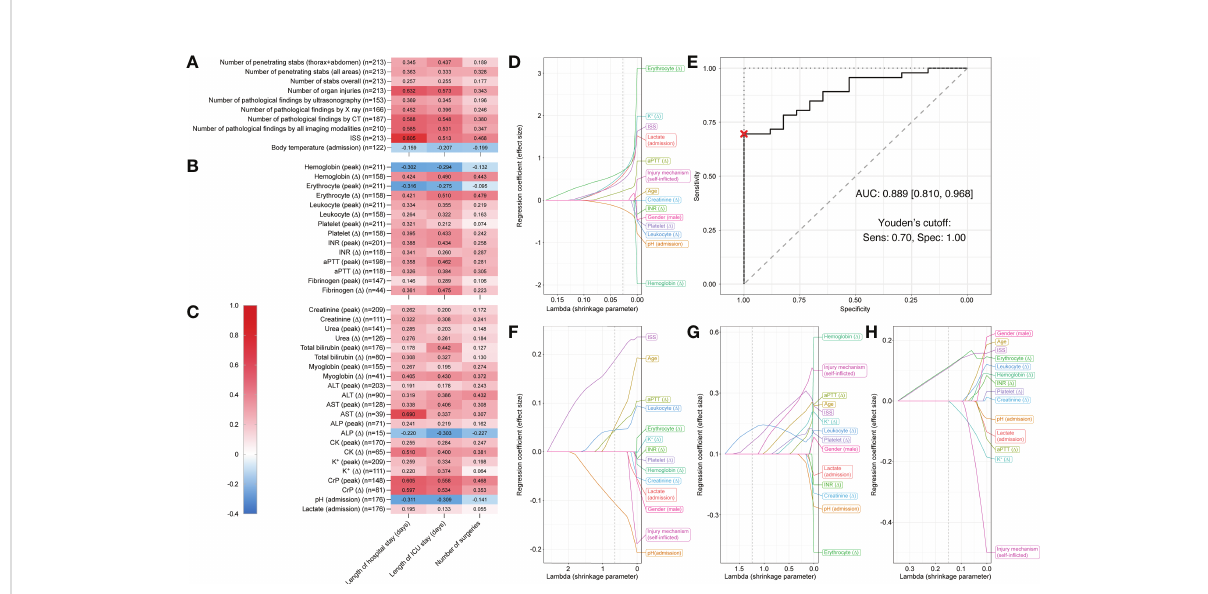
FIGURE 2 Correlation matrix showing Spearman ’ s rank correlation coef fi cients and Least Absolute Shrinkage and Selection Operator (LASSO) plots showing regression coef fi cients for patients who suffered penetrating stab injuries. Correlation strength is indicated by color scale on the left. Correlations between three different outcome parameters (length of hospital stay, length of ICU stay, and number of surgeries) and (A) injury speci fi cs, (B) routine hematology and coagulation, and (C) serum biochemistry and venous blood gas laboratory parameters for penetrating injuries (n = 213). Multivariable LASSO trace plots indicate potentially predictive sets of variables for (D) ICU admission (yes/no). (E) Receiver operating characteristic (ROC) curve for the LASSO model of ICU admission (yes/no). Youden ’ s cutoff indicates the optimal cutoff based on sensitivity (Sens.) and speci fi city (Spec). (F) Further LASSO trace plots for length of hospital stay, (G) length of ICU stay, and (H) number surgeries. Grey dotted line displays optimal lambda value calculated via cross-validation. AUC, area under the